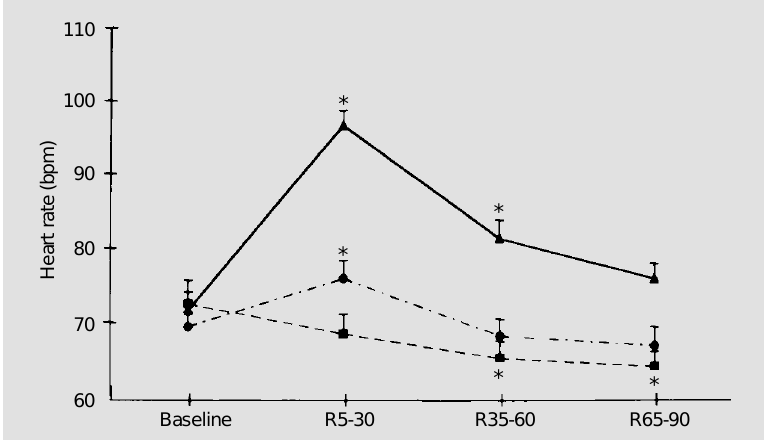
Figure 2 - Heart rate at baseline and after exercise (R5-30, mean value between 5 and 30 min; R35-60, mean value between 35 and 60 min; R65-90, mean value between 65 and 90 min) performed at 30 (filled squares), 50 (filled circles) and 80% (filled triangles) of VO 2 peak. *P<0.05 compared to baseline (two-way analysis of variance for repeated measures and Scheffé ’ s post-hoc